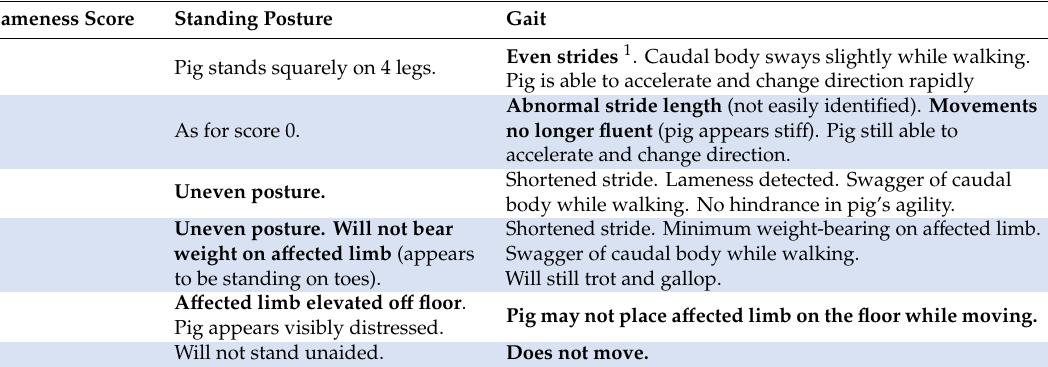
Table 3. Visual scoring protocol modified from Main et al. [30].